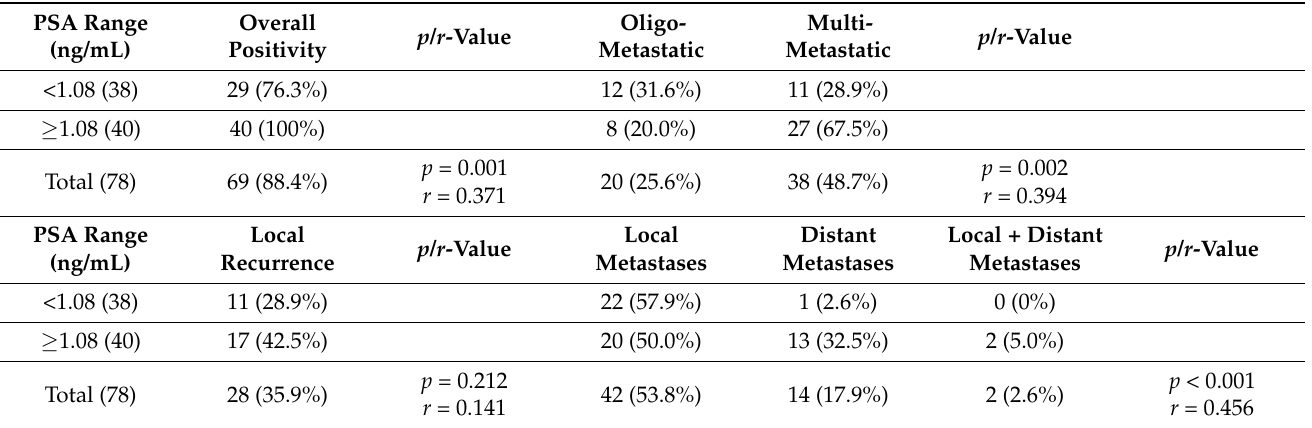
Table 7. [ 18 F]PSMA-1007 PET/CT in 78 patients initially treated with radical prostatectomy (F-RP): subgroups of patients according to the number of PSMA-positive lesions categorized by pre-scan PSA threshold 1.08 ng/mL.